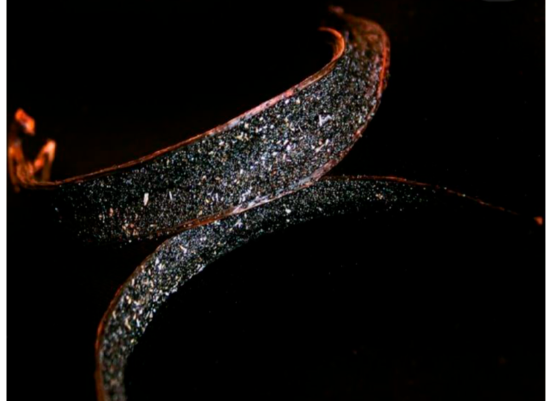
Figure 2. Open fruit of Vanilla sp. with vanillin crystals. Photo by: Marcelo Kuhlmann retrieved from “Frutos Atrativos do Cerrado” Project (http://www.frutosatrativosdocerrado.bio.br and @marcelo_kuhlmann Instagram profile, Accessed on 20 October